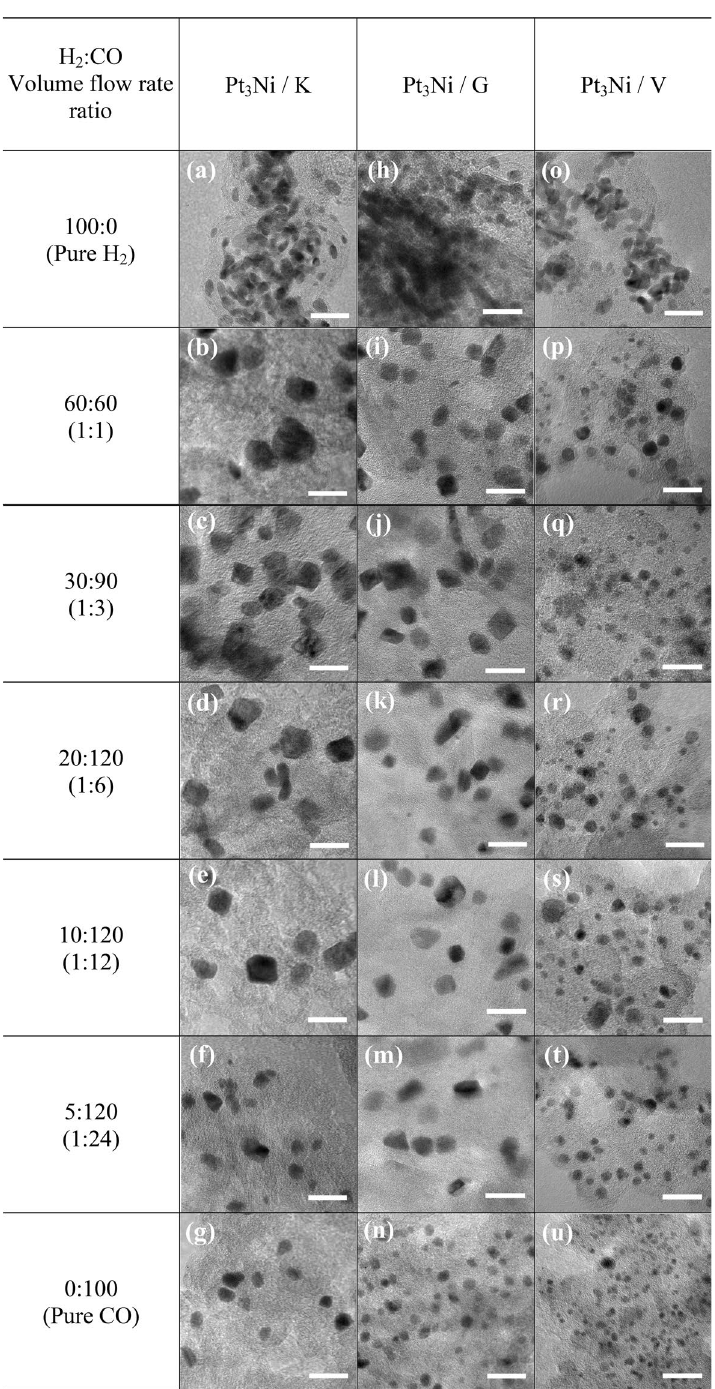
Figure 1. The TEM images of Pt 3 Ni/C nanoparticles reduced with different H 2 :CO volume flow rate (cm 3 min −1 ) ratios; ( a )–( g ) for Ketjen black; ( h )–( n ) for Graphene; and ( o )–( u ) for Vulcan XC-72R carbon supports. The scale bar in all TEM images represents 20